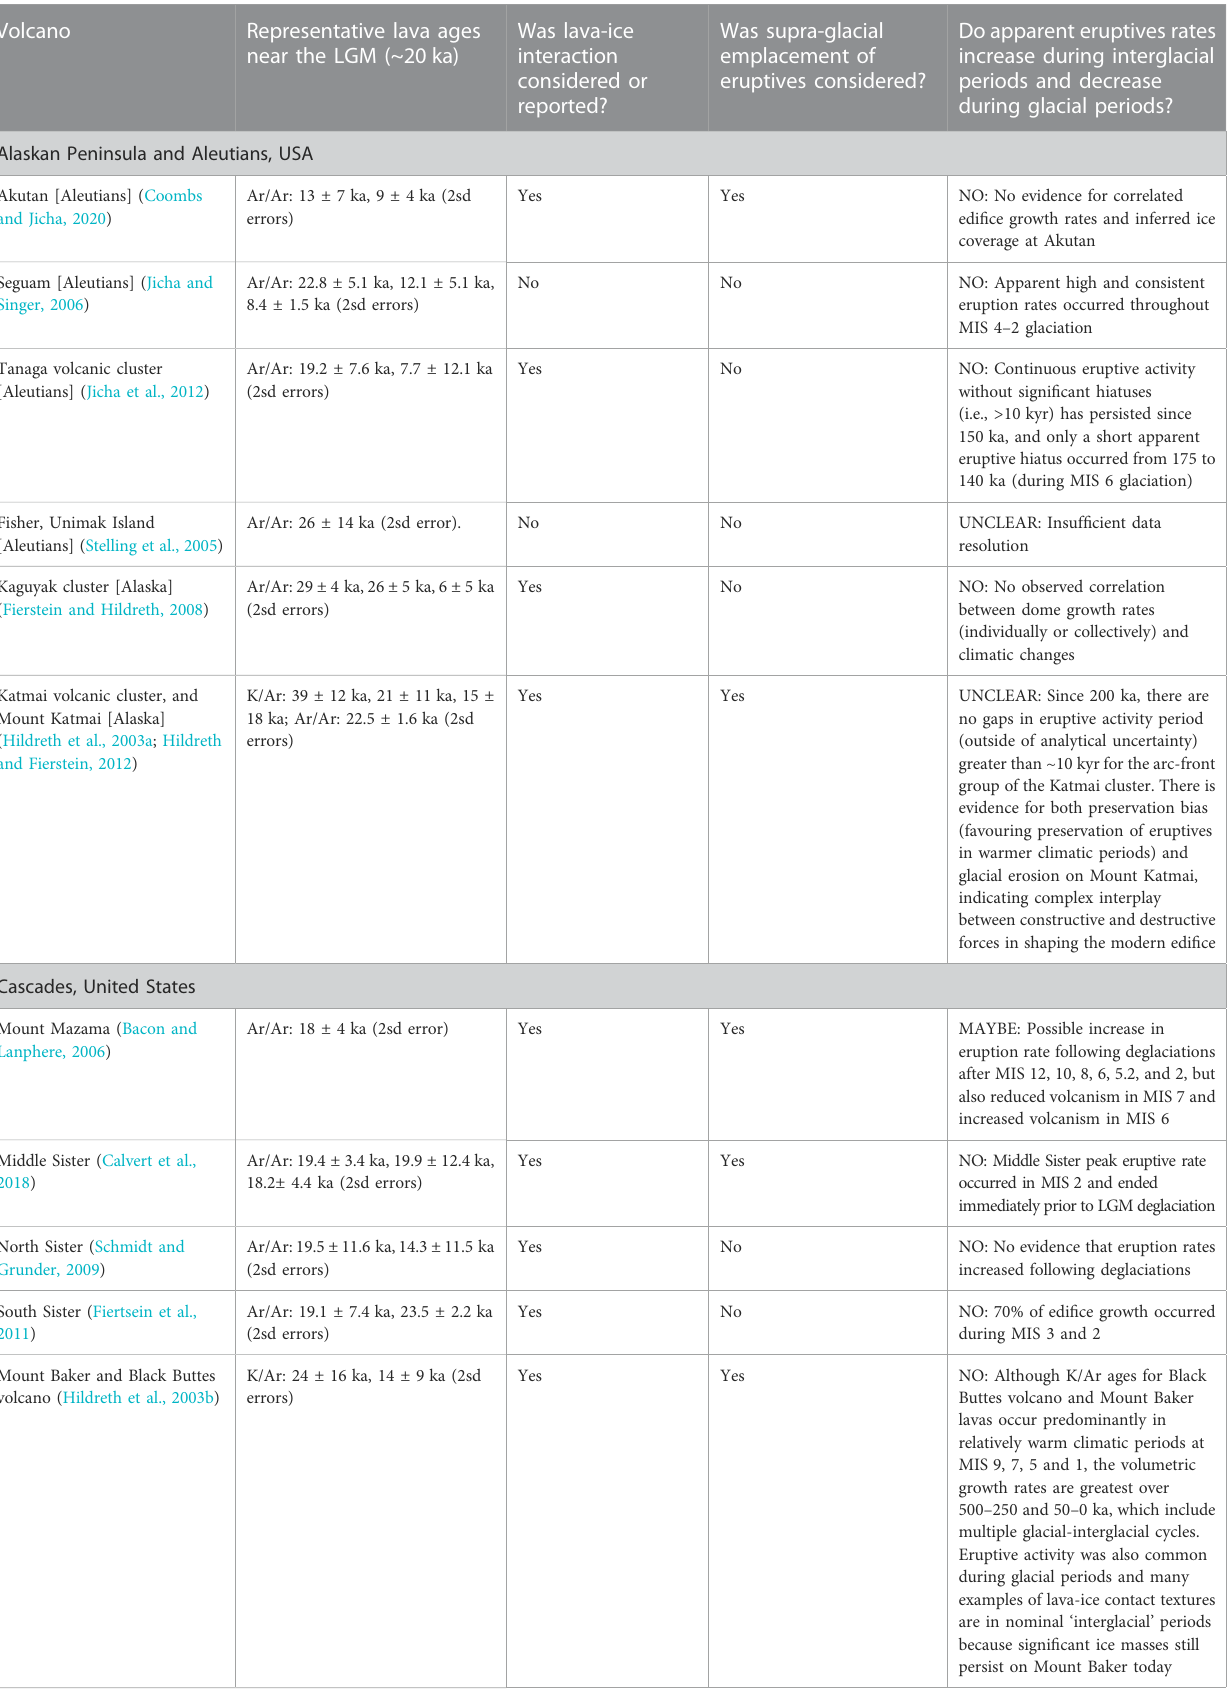
TABLE 2 Summary of geochronological precision, preservation considerations, and time-volume correlations with climatic changes. The radiometric ages and other summarized information are from the references in Table 1, unless otherwise noted. Volcano Representative lava ages near the LGM (~20